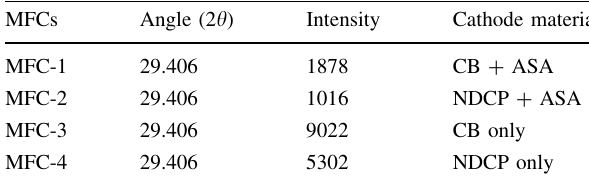
Table 4 Data from XRD analysis of the